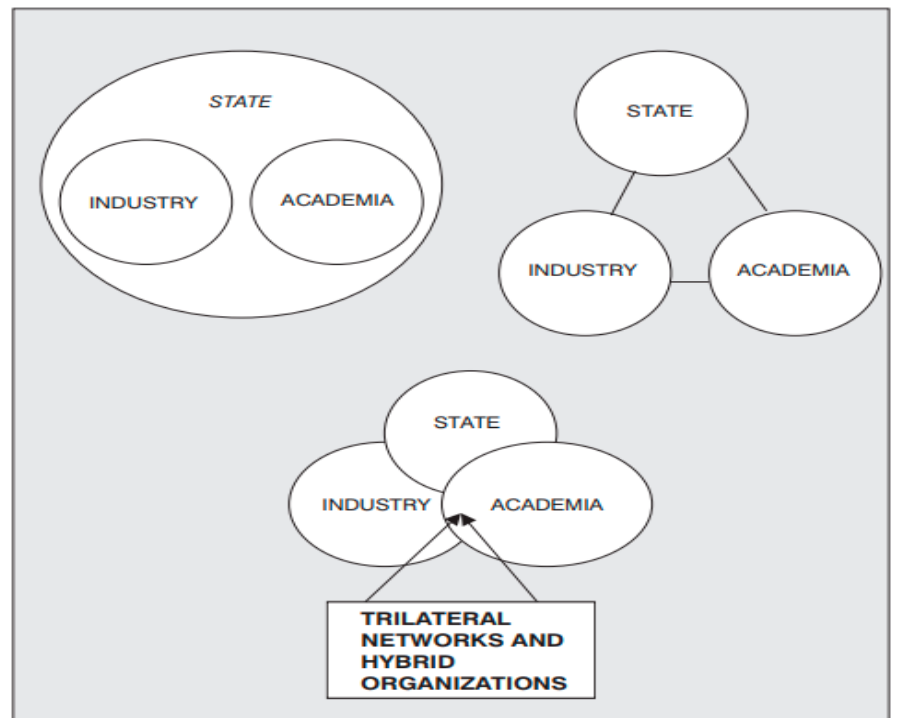
Figure 1. Triple Helix configurations.